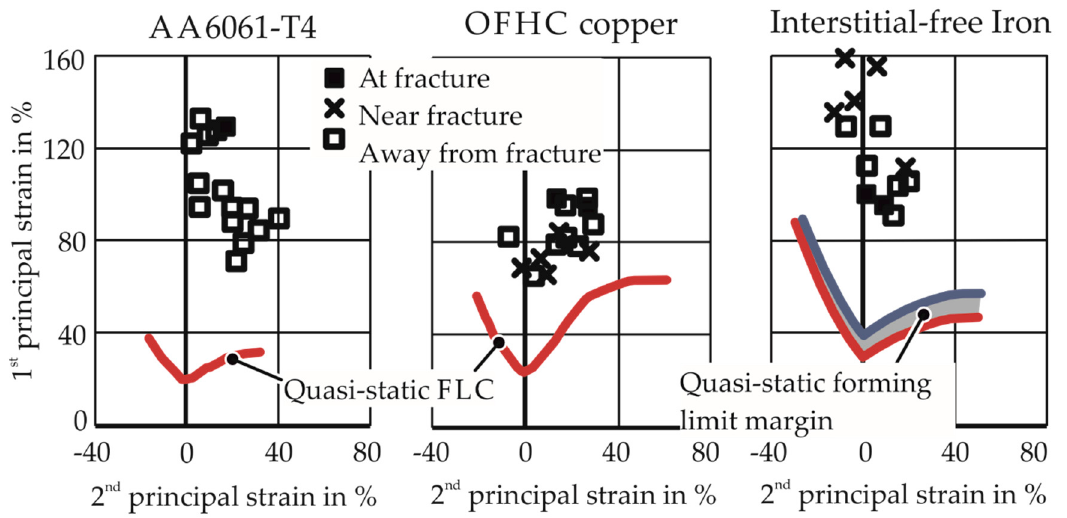
Figure 2. Forming limits observed by Balanethiram and Daehn [6,7]. Free electrohydraulic forming into a round die opening.